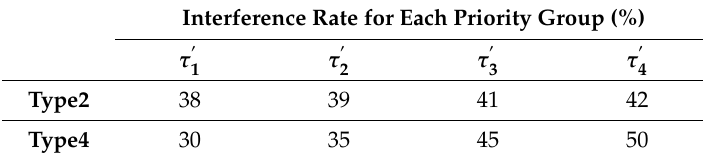
Table 4. UEP parameter settings for the average of the interference ratio, τ (cid:48) =